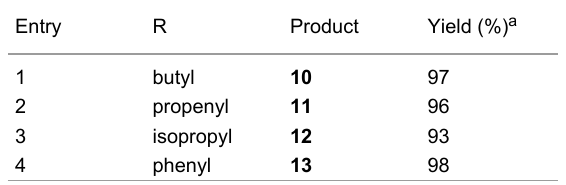
Table 3: Intramolecular inverse electron-demand Diels–Alder reac- tions under microwave irradiation. Entry